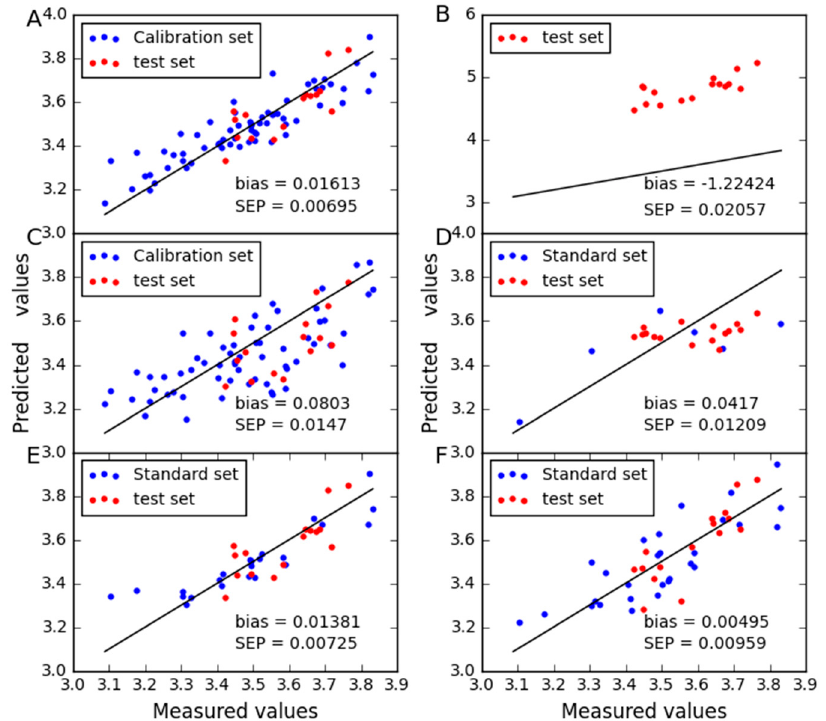
Figure 4. Oil content predicted for corn dataset as determined by ( A ) CTAI, ( B ) MSC, ( C ) TCR, ( D ) CCA, ( E ) SBC and ( F ) PDS. The blue and red dots represent the results for each sample in the train set and test set, respectively.